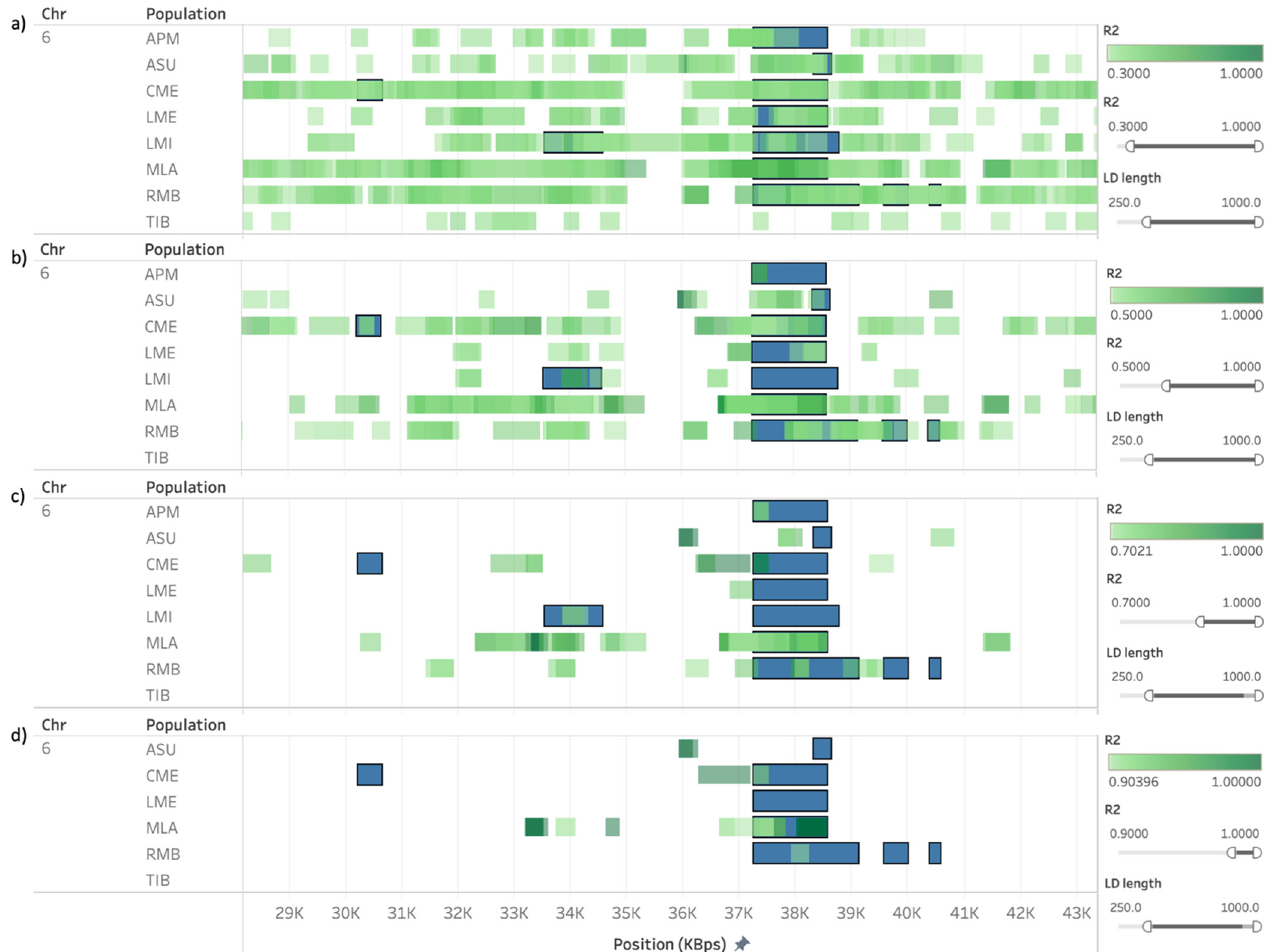
Figure 7. Runs of homozygosity (ROH) islands (blue) plotted against SNP pairwise calculation of r 2 (green) in OAR6 (29–43 Mb). Regions in linkage disequilibrium (LD) were restricted to SNP distances between 250 and 1000 kb, and the r 2 threshold was set to 0.3 ( a ), 0.5 ( b ), 0.7 ( c ), or 0.9 ( d ). Only rows where both ROH islands were present and LD met the thresholds were presented, as a default and immutable requirement of Tableau’s visualization.